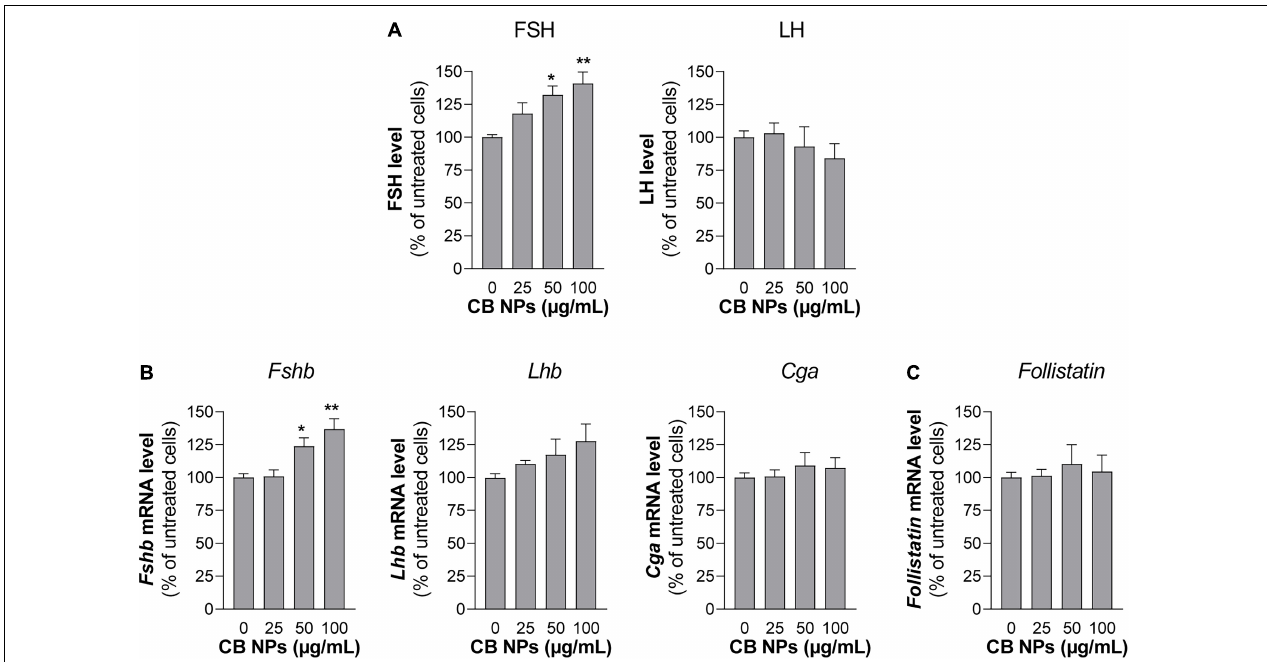
FIGURE 3 | Gonadotropin secretion and gene expression in primary cultures of anterior pituitary cells treated with CB NPs. Rat primary anterior pituitary cells were cultured for 24 h with increasing concentrations of CB NPs (25–100 µ g/mL). At the end of the incubation, FSH and LH concentrations in the culture media of primary pituitary cells were determined by ELISA. FSH/LH ratio is also shown in panel (A) . Total RNAs were extracted and Fshb , Lhb , Cga (B) and Follistatin (C) mRNA levels were determined by real-time quantitative PCR. Data are expressed as percentage over untreated cells and expressed as means ± SEM from 4 independent experiments. Statistical differences were determined by non-parametric Kruskal-Wallis test followed by Dunnet’s multiple comparison test. * p < 0.05 and ** p < 0.01 compared to no CB